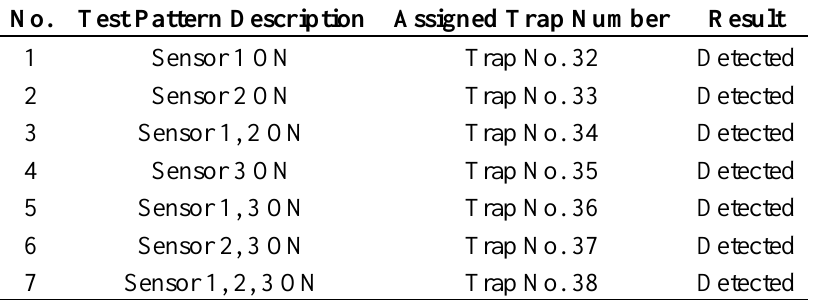
Table 1. Trap number assignment for the SPR sensors and detection